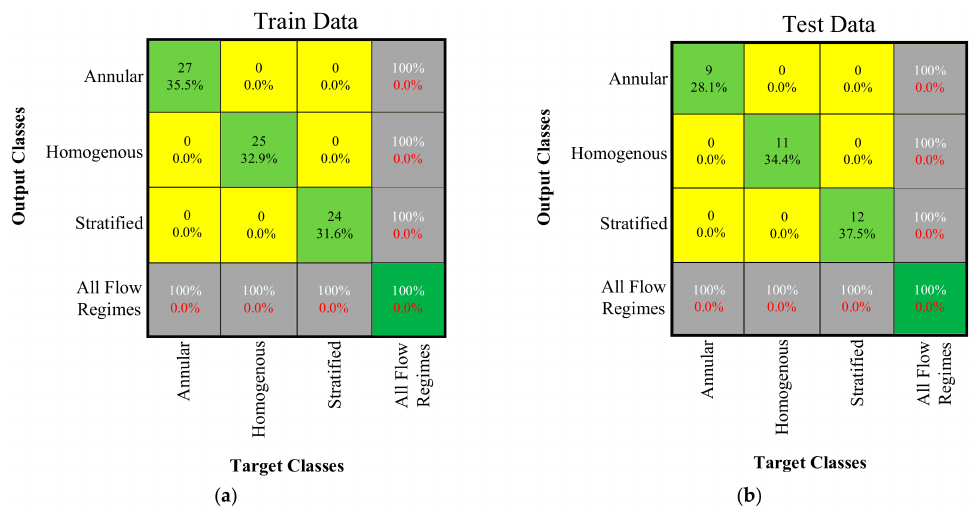
Figure 5. Performance of classifier network for ( a ) training and ( b ) testing data.